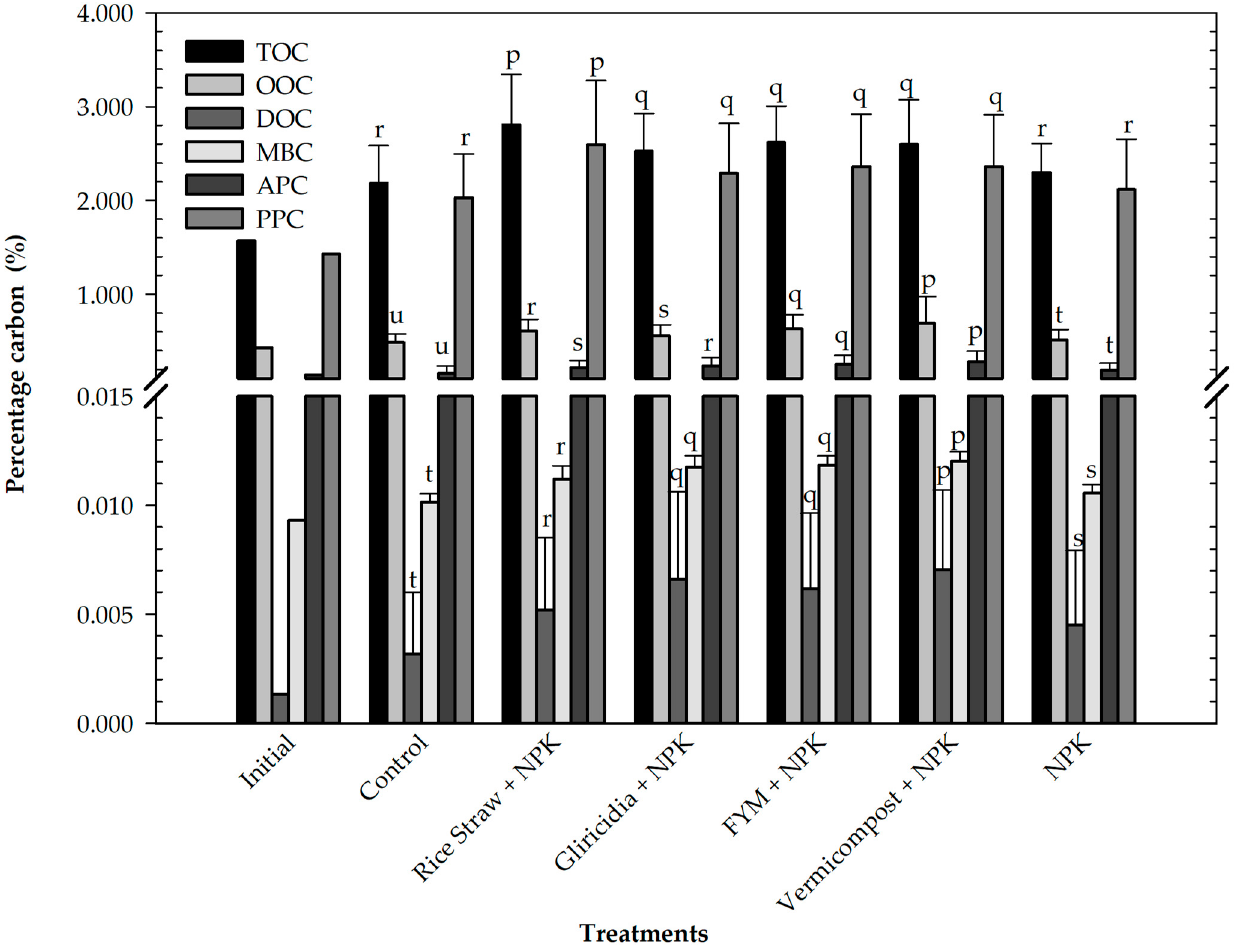
Figure 2. Effects of treatments on different pools of organic carbon (%) in the rice rhizosphere soil. The values are the averages and error bars are the standard deviations of measurements over three crop growth stages through three consecutive crop growing seasons. Bars followed by the same letter (within and between stacks) are not significantly different at p < 0.05. TOC (total organic carbon), OOC (Oxidizable organic carbon) DOC (dissolved organic carbon), MBC (microbial biomass carbon), APC (active pool of carbon), PPC (passive pool of carbon).